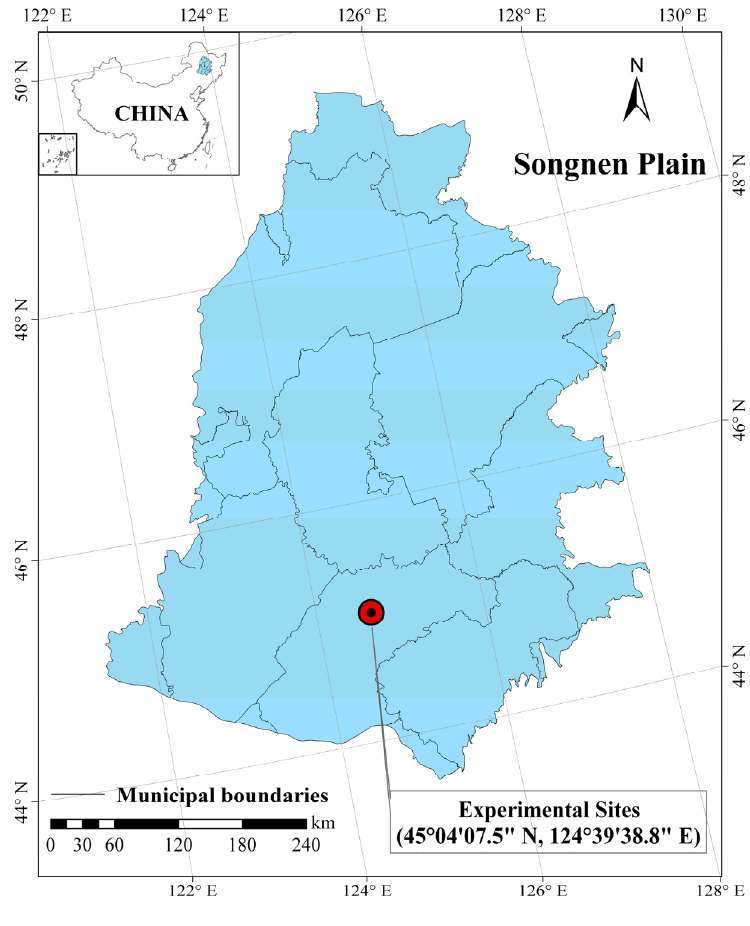
Figure 1. Geographical location of the study site in Jilin Province, Northeast